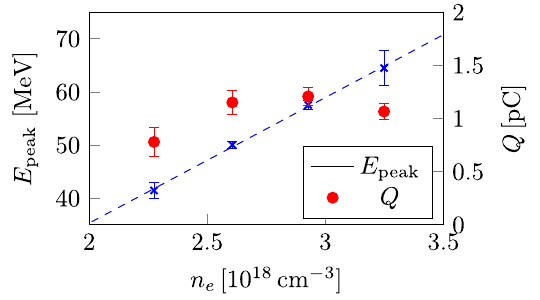
FIG. 3. Peak energy against relative jet position along the optical axis for two different plateau densities. The acceleration length in the plateau after the density down-ramp is controlled by the position of the gas jet. Zero on the x-axis corresponds to the position where the density down-ramp is approximately centered in the density distribution from the jet. Each data point corre- sponds to 10 consecutive shots and the error bars indicate one standard deviation in each direction. While the electron number density in the peak is kept constant at 11 × 10 18 cm − 3 , the peak energy increases linearly (dashed blue line) with the relative jet position.